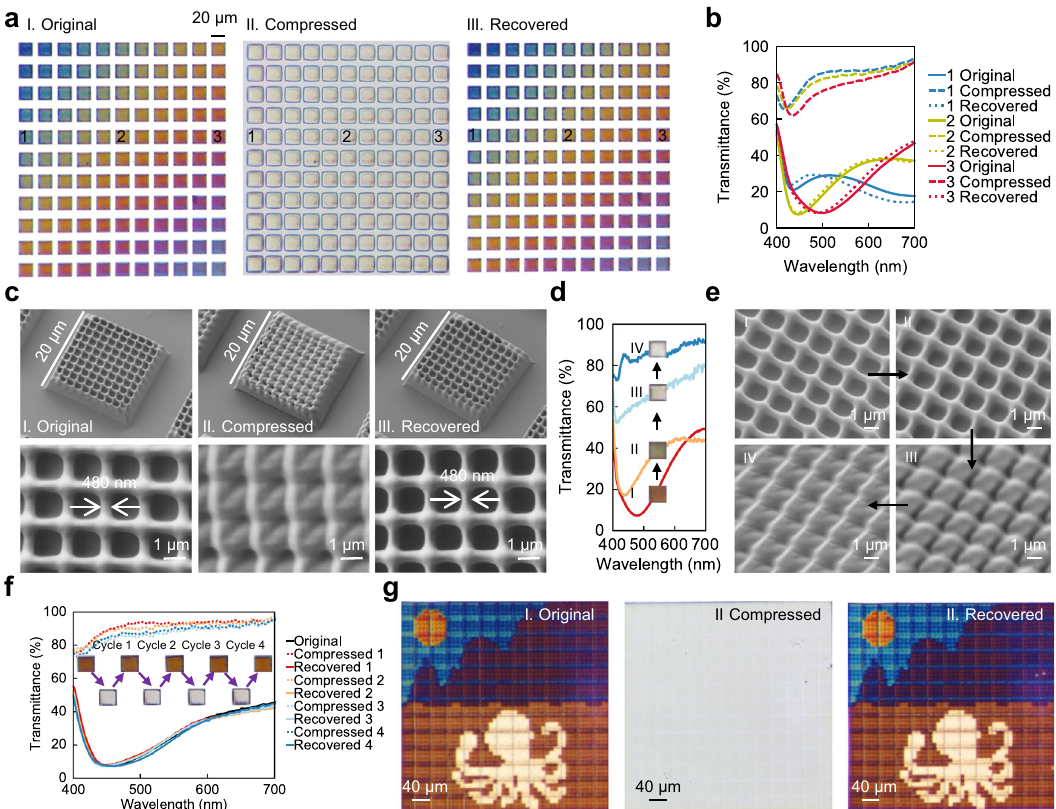
Fig. 4 Submicron scale shape memory effect. a Different colours as printed, compressed and recovered respectively, observed by the objective lens (NA = 0.2, CA = 11.5°) at the transmittance mode (in the colour palette, the laser power was varying from 30 to 35 mW with a step of 0.5 mW in the transverse direction, and the write speed was varying from 0.6 to 1.1 mm/s with a step of 0.05 mm/s in the vertical direction). b Comparison of measured spectra of three different grid structures (marked as number 1, 2, 3 in Fig. 4a) as printed, after programming and after recovery. c Tilted (30° tilt angle) and top view of SEM images before and after programming and after recovery. d Measured spectra and e SEM images for a structure programmed into different degree of fl atness. f Measured spectra of a grid structure for four programming cycles. g The painting as printed, compressed, and recovered,